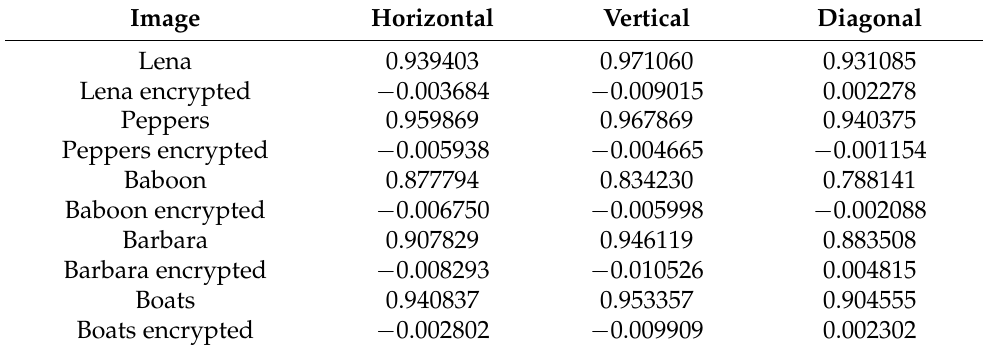
Table 9. Correlation coefficients of two adjacent pixels in the plain and ciphered images. Image Horizontal Vertical Diagonal Lena 0.939403 Lena